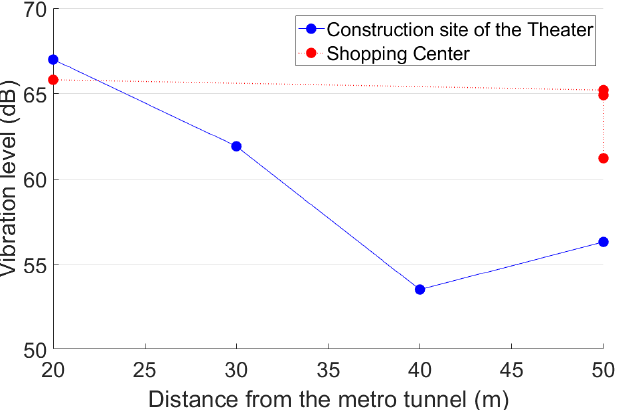
Figure 18. Development of ground vibration along the horizontal distance from the metro tunnel.